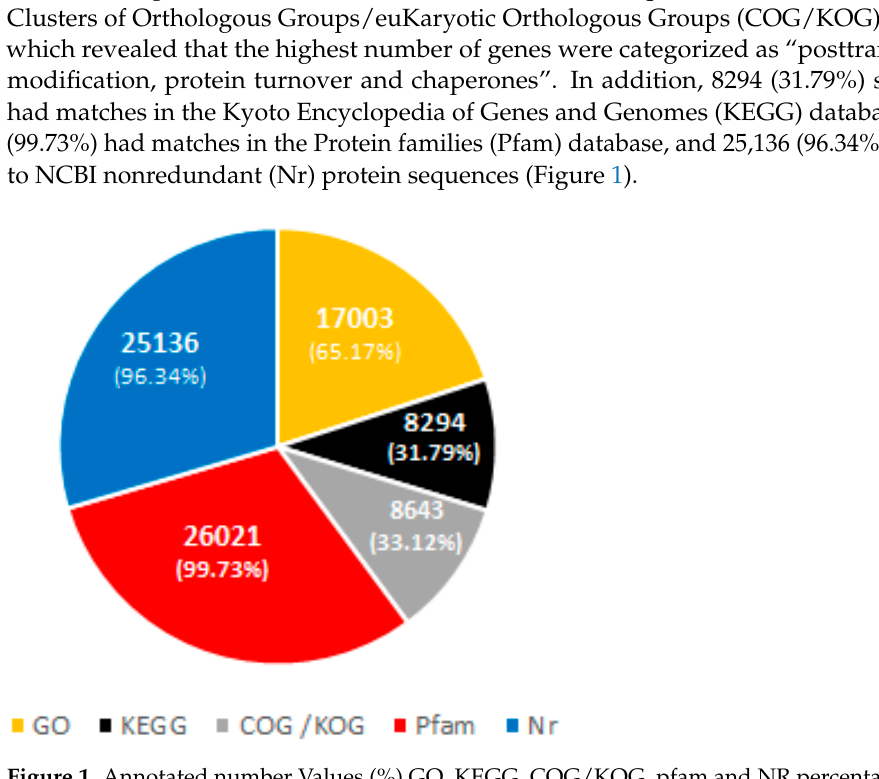
Figure 1. Annotated number Values (%) GO, KEGG, COG/KOG, pfam and NR